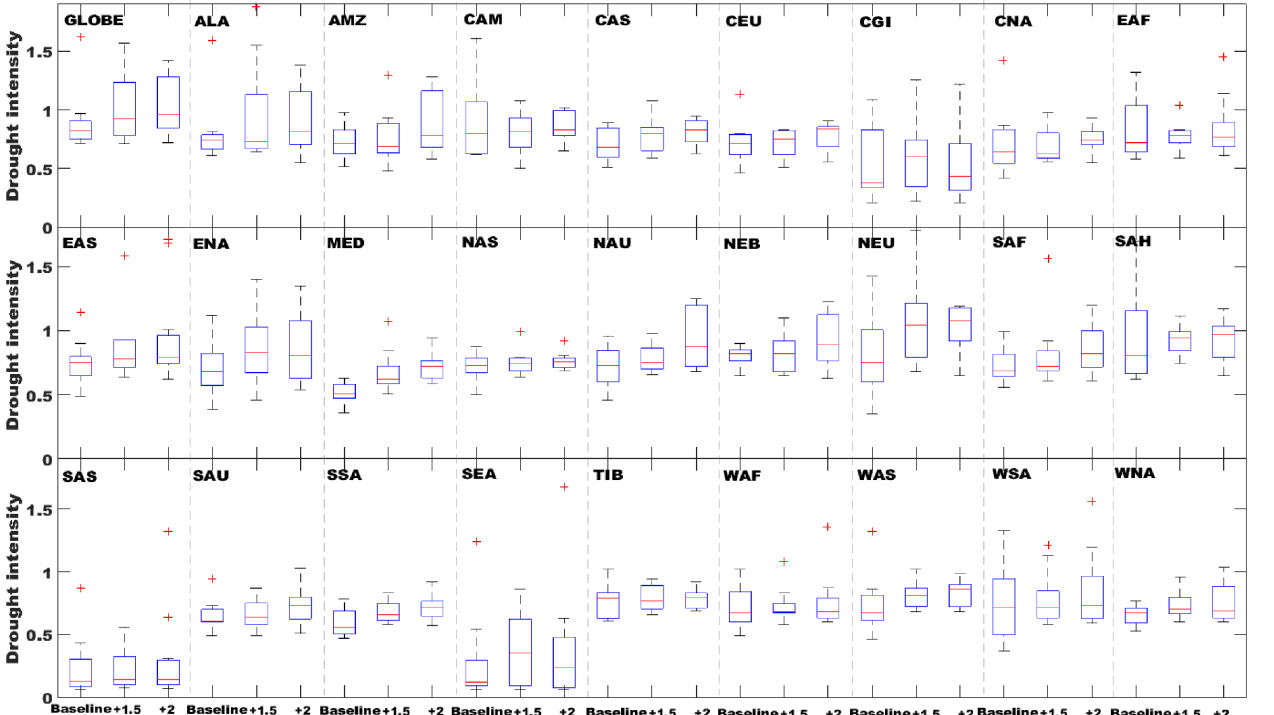
Figure 8. Multi-model projected drought intensity (dimensionless) globally (66 ◦ N–66 ◦ S) and in 27 world regions for the baseline period and the 1.5 and 2 ◦ C warmer worlds. The projected uncertainty of multiple climate models is shown through box plots for each region and for each